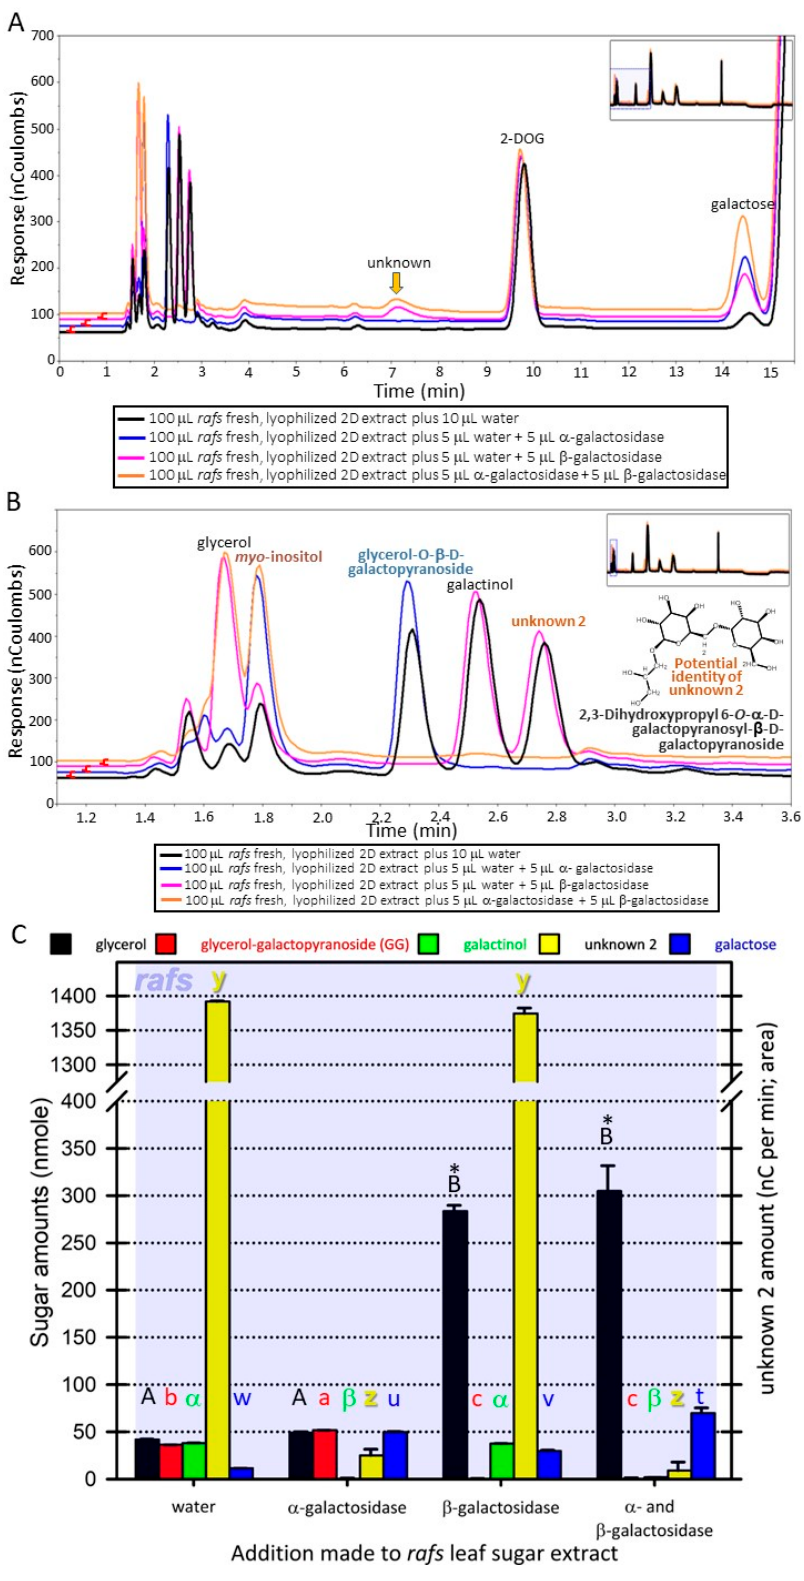
Figure 3. Further verification of the identity of unknowns in maize leaf carbohydrate extracts. The same extracts hydrolyzed in Figure 2 were hydrolyzed again but with both α - and β -galactosidase added simultaneously as another treatment (orange trace). ( A ) Galactose amounts increased above that for unhydrolyzed sample when hydrolyzed by α -galactosidase (blue trace; from galactinol